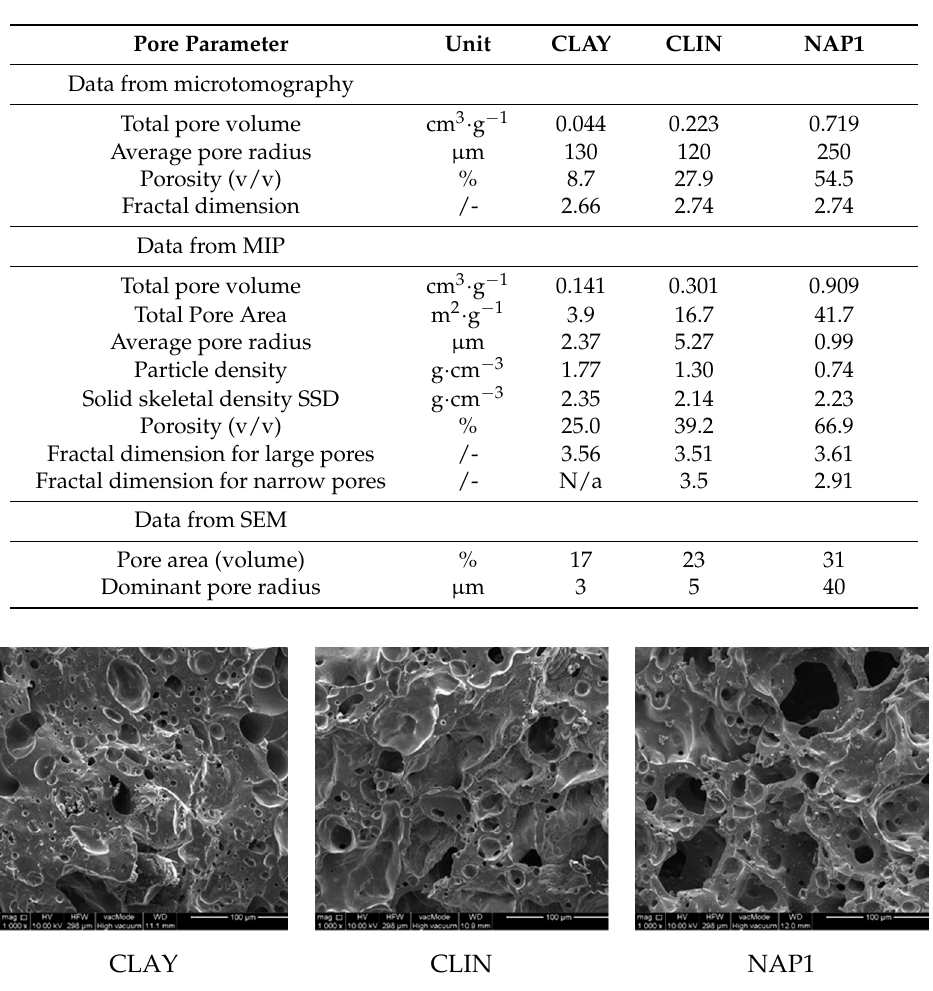
Figure 8. Representative scanning electron microscope microphotographs (SEM) of the studied aggregate sections.